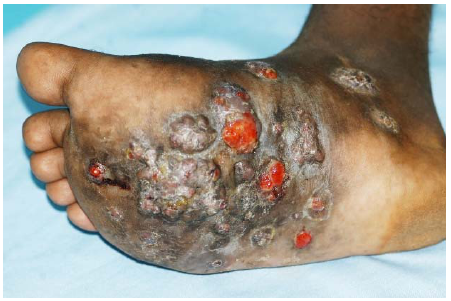
Figure 4. Foot eumycetoma with skin hyperpigmentation, multiple nodules and active sinuses.